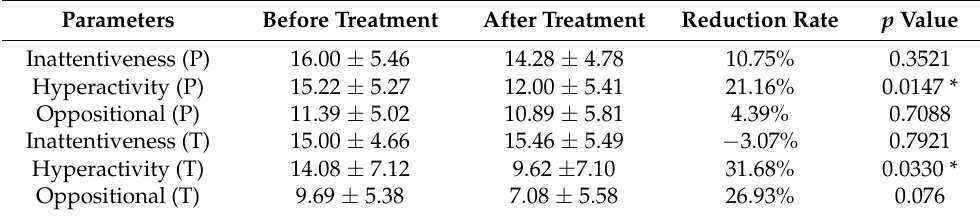
Table 2. Comparison of subscales of SNAP in patients of ADHD before and after